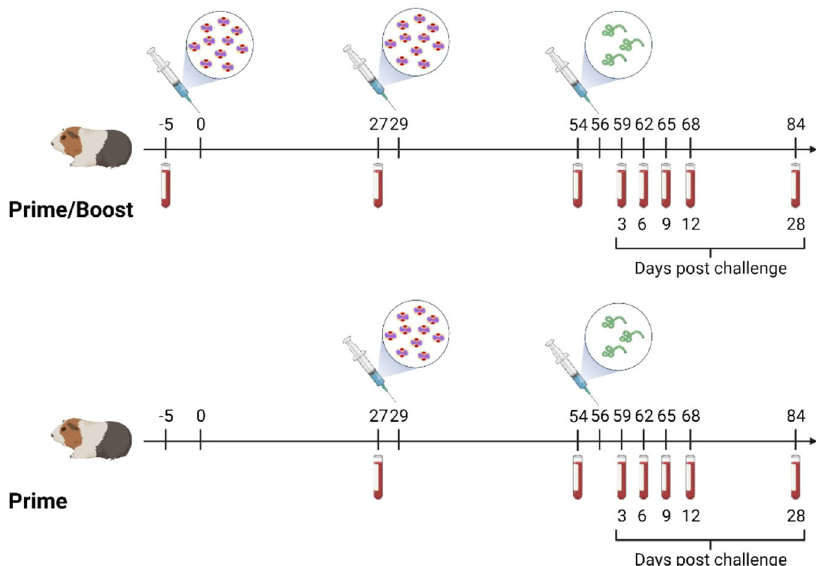
Fig. 2 Study design. Dunkin-Hartley guinea pigs ( N = 5 per group) were vaccinated with the MVA-SUDV vaccine IM either once (prime group) or twice (prime/boost group) at 29 days interval while the control group received PBS (not shown). Serum collected on days 27 and 54 was assessed for humoral responses. On day 56, all animals were challenged IP with guinea pig-adapted SUDV. Blood was collected on day 27 post vaccination and on the indicated days post challenge to assess humoral responses and vaccine ef fi cacy. Figure partially created on BioRender.com.